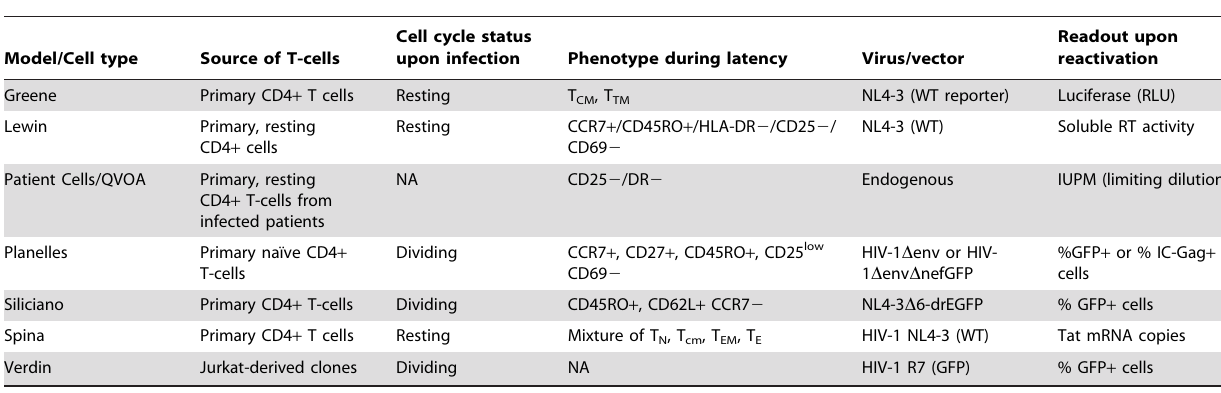
Table 1. Properties of the models used in this